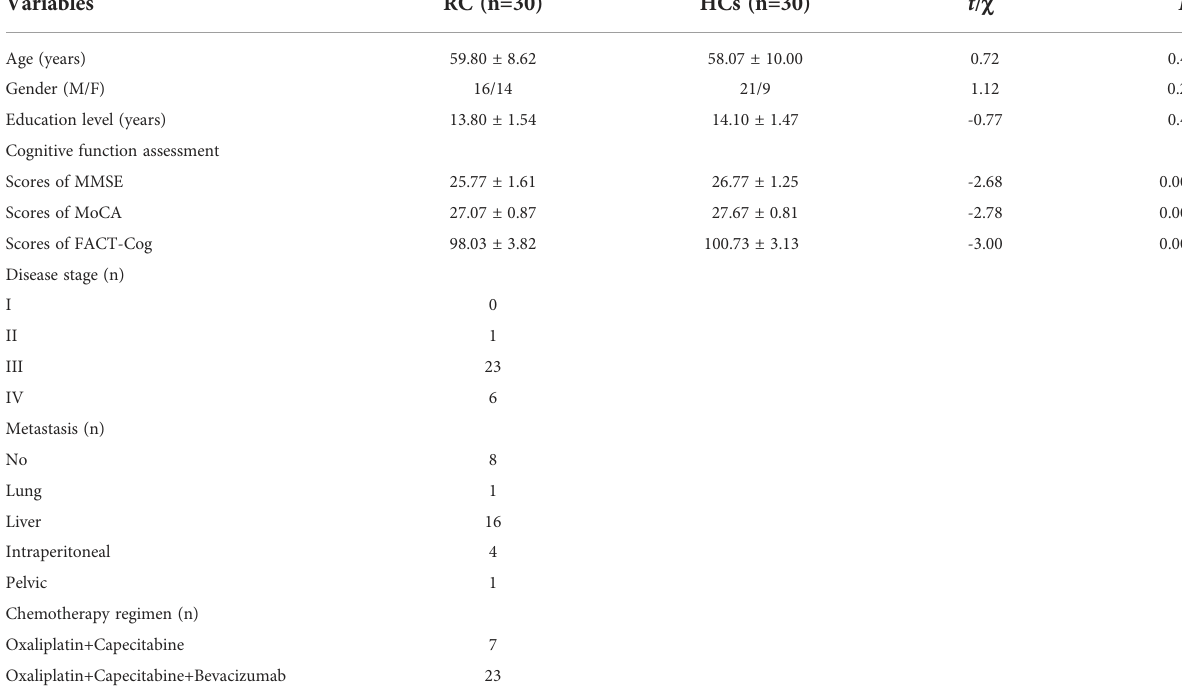
TABLE 1 Demographic and clinical characteristics of